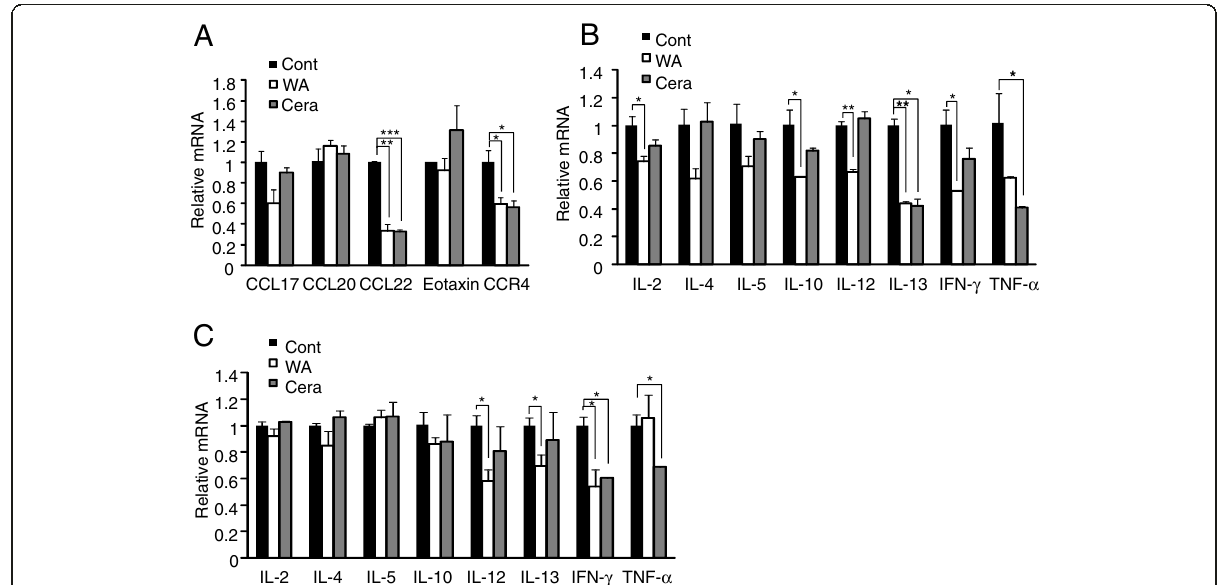
Figure 5 Water soluble extract of P. linteus (WA) inhibits the expression of pathogenic cytokines and chemokines in ear. After final treatment, mice of each group were sacrificed and ears were removed. ( A, B ) Total ear cells were stimulated with PMA (0.5 μ g/ml) and ionomycin (1 μ M) for 4 hrs, then mRNA expression of chemokines ( A ) and cytokines ( B ) were determined by quantitative RT-PCR. (C) CD4+ T cells isolated from ear total cells were stimulated and cytokine levels were measured by quantitative RT-PCR. The mRNA expression levels in each group were normalized with L32 (house- keeping gene) and then fold induction of each target gene were compared to Cont (PBS) group. Error bars indicated S.D. One (*), Two (**) and three asterisk (***) indicates P<0.05, P<0.005, P<0.001, respectively. Data are representative of three independent